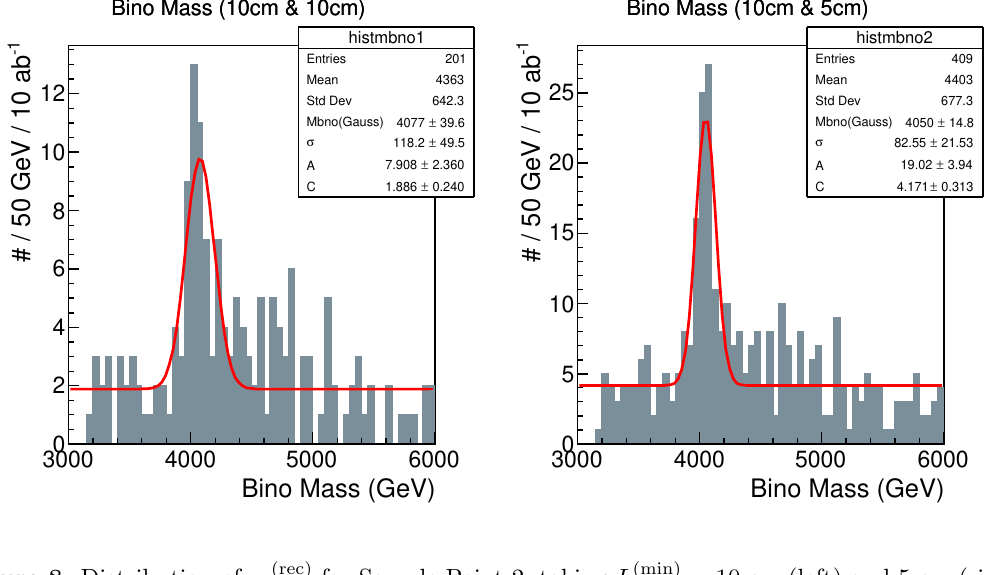
Figure 8 . Distribution of m (rec) in a single experiment with the integrated luminosity of L = 10 ab (cid:0) 1 .